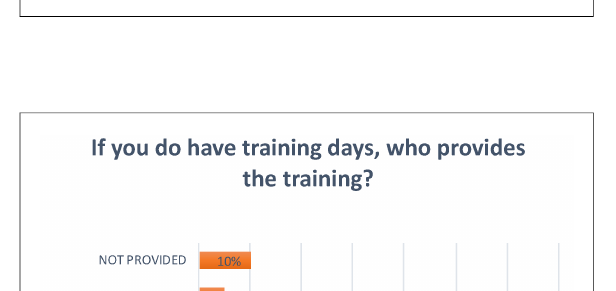
FIGURE 12 If you do have training days, who are they aimed at? 50% of nurseries aim training at adults, such as parents and educators; 15% only target the children. 35% target both adults and children.